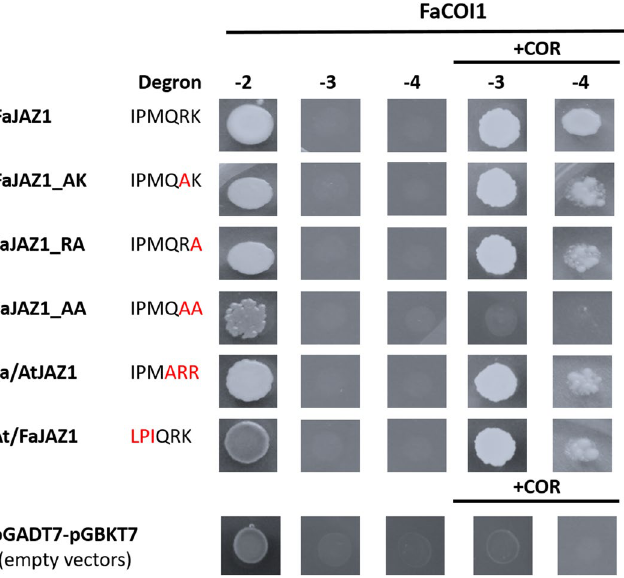
Figure 8. Yeast two-hybrid (Y2H) assays for Fragaria × ananassa JAZ1 mutants- and chimeras-COI1 interactions. Interactions of FaCOI1 with native (FaJAZ1), single (FaJAZ1_AK and FaJAZ1_RA) and double (FaJAZ1_AA) mutants, and chimeras (Fa/AtJAZ1 and At/FaJAZ1) of JAZ1 under absence/presence of COR. Negative controls with pGADT7-(AD) and pGBKT7-(DBD) empty vectors under the absence/presence of COR. − 2, SD-Leu-Trp; − 3, SD-Leu-Trp-His; − 4, SD-Leu-Trp-His-Ade; Fa, Fragaria × ananassa ; COI1, CORONATINE INSENSITIVE1; COR, coronatine; JAZ, JASMONATE